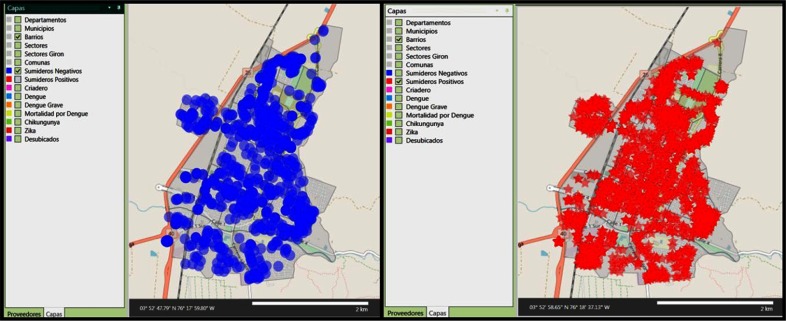
Location of Catch Basins Surveyed in Buga, Colombia, September 2017Negative catch basins (Sumideros Negativos) indicated by blue dots and positive catch basins (Sumideros Positivos) indicated by red stars.